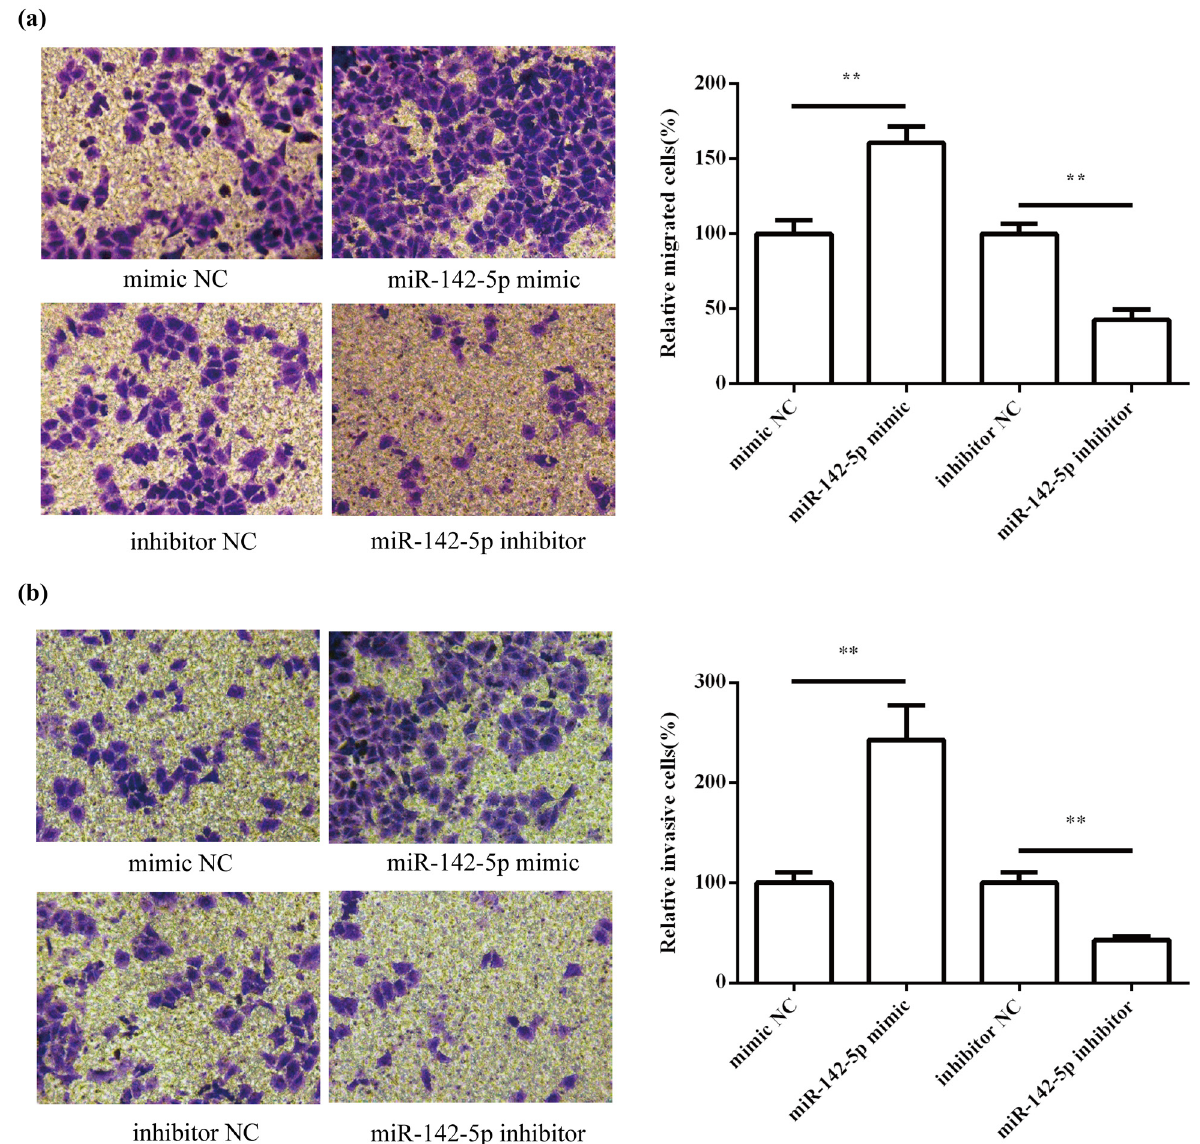
Figure 3: E ff ects of miR - 142 - 5p on HeLa cell migration and invasion. The e ff ect of miR - 142 - 5p on cell migration ( a ) and invasion ( b ) was detected by transwell assay. All experiments were performed in triplicate. ** P <